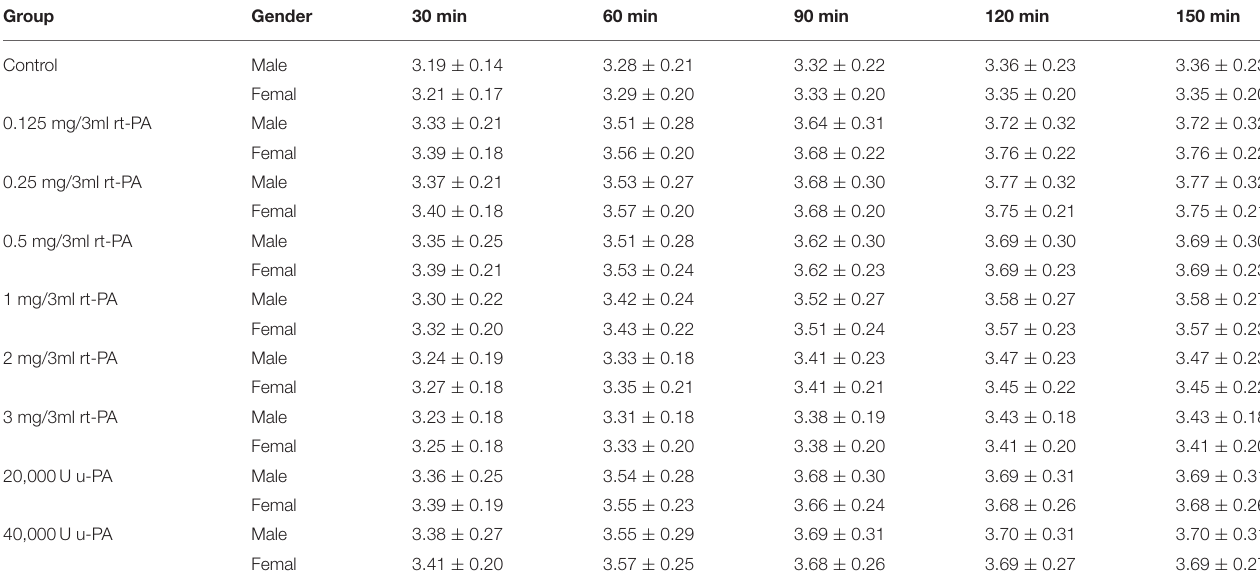
TABLE 4 | Effect of drugs concentration on the hemolytic efficiency between male and female. Group